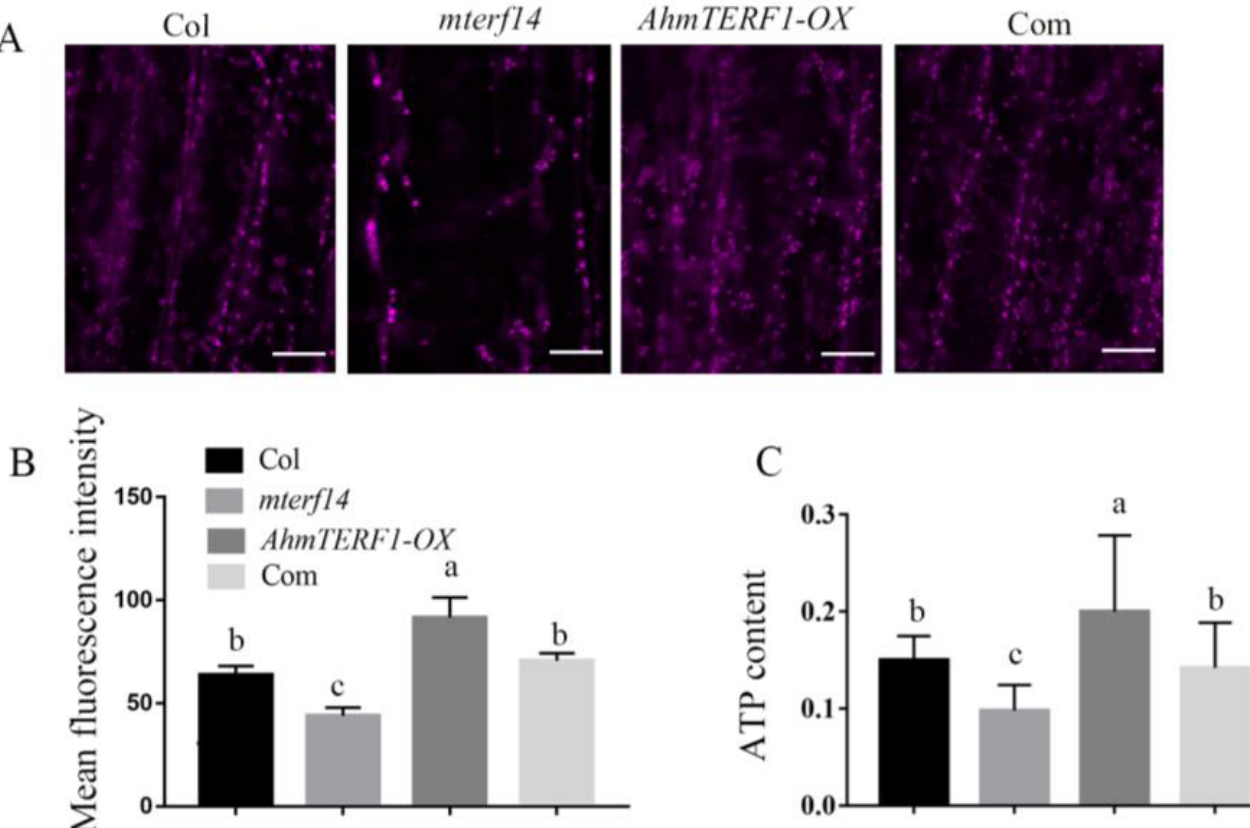
Figure 6. Mitochondria and ATP content are increased in AhmTERF1-OX Arabidopsis . ( A ): Images of mitochondria in the root tip of 3-d old Arabidopsis taken by confocal laser scanning microscope (LSM800, Carl Zeiss, Germany). Scale bars: 5 µ m. MitoTracker was used as a mitochondrial marker. ( B ): Fluorescence intensity of A. ( C ): ATP content of the roots of 3-d old Arabidopsis seedlings. ATP content was calculated as µ mol/g. Com indicates 35S:AhmTERF1/mterf14 Arabidopsis plants. Lower case letters (a, b, c) indicate significantly different groups ( p < 0.05).